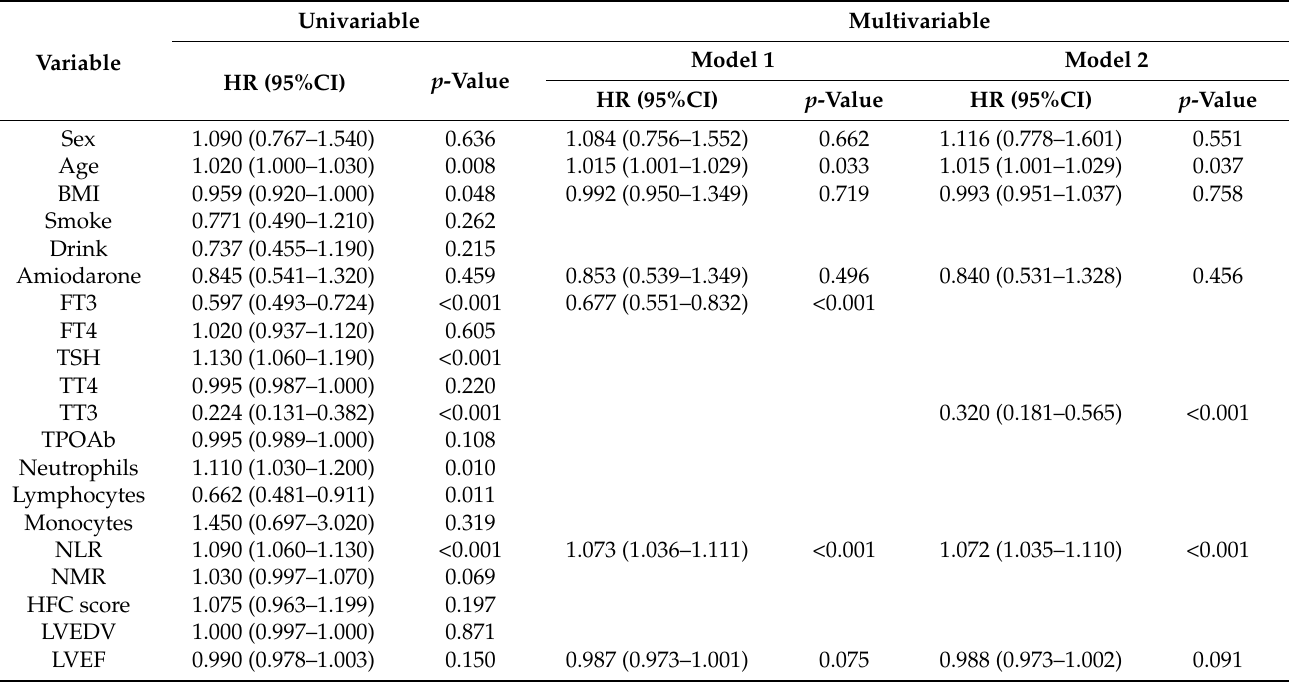
Table 2. Univariable and multivariable COX regression analyses for independent risk factors of adverse hospital events in included